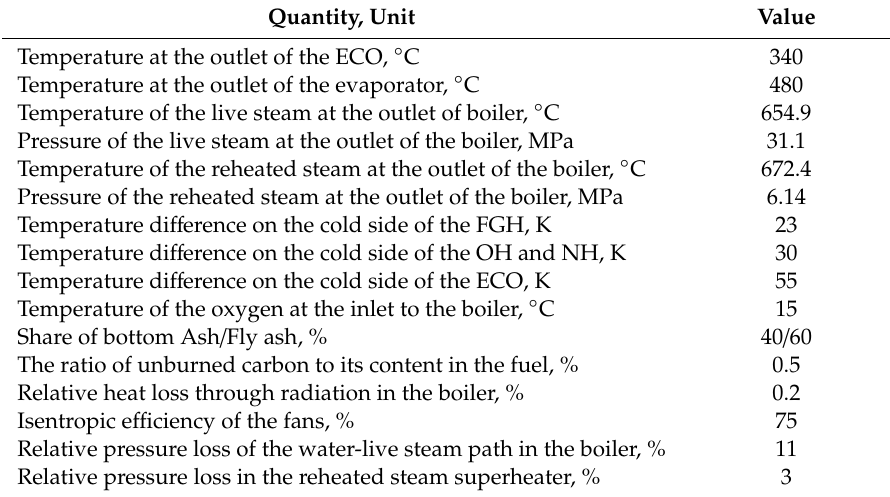
Table 3. Assumptions for an oxy-type fluidized-bed boiler (variant